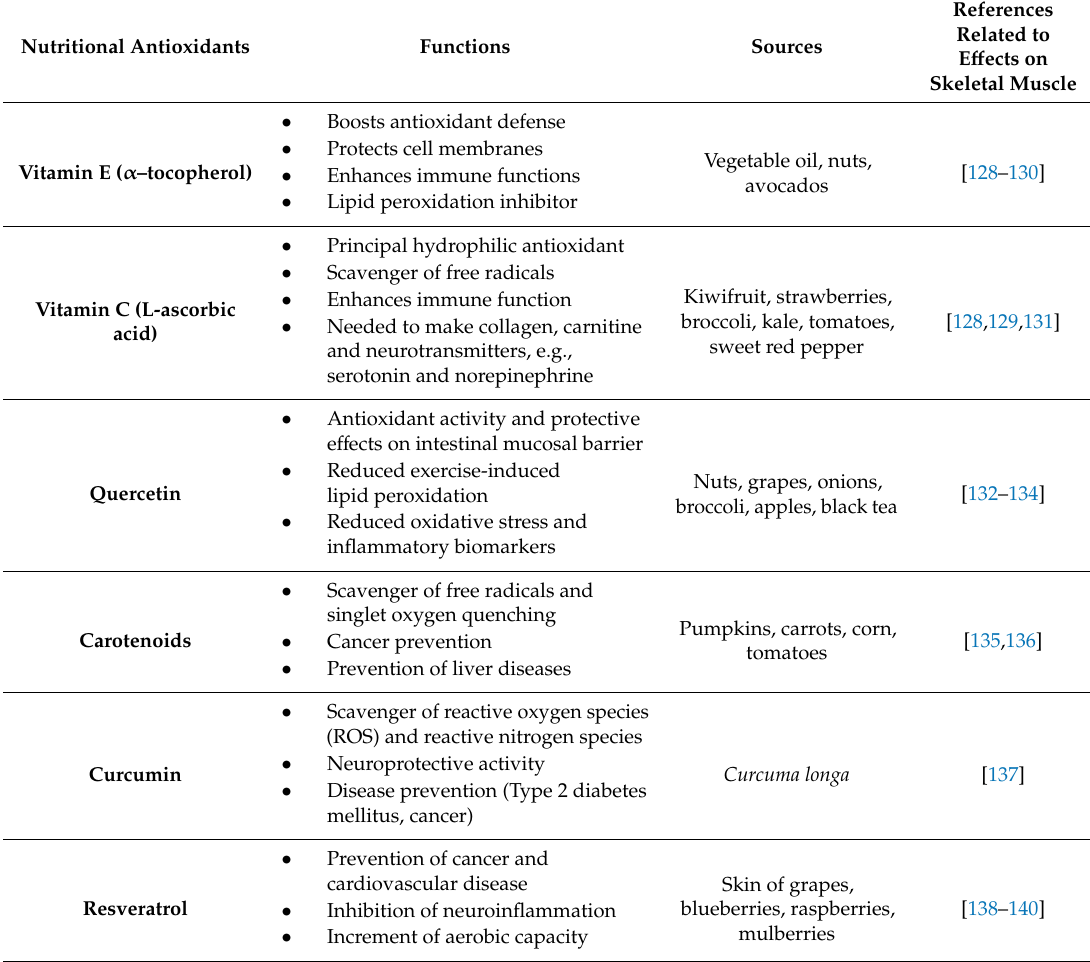
Table 1. Functions and sources of principal nutritional